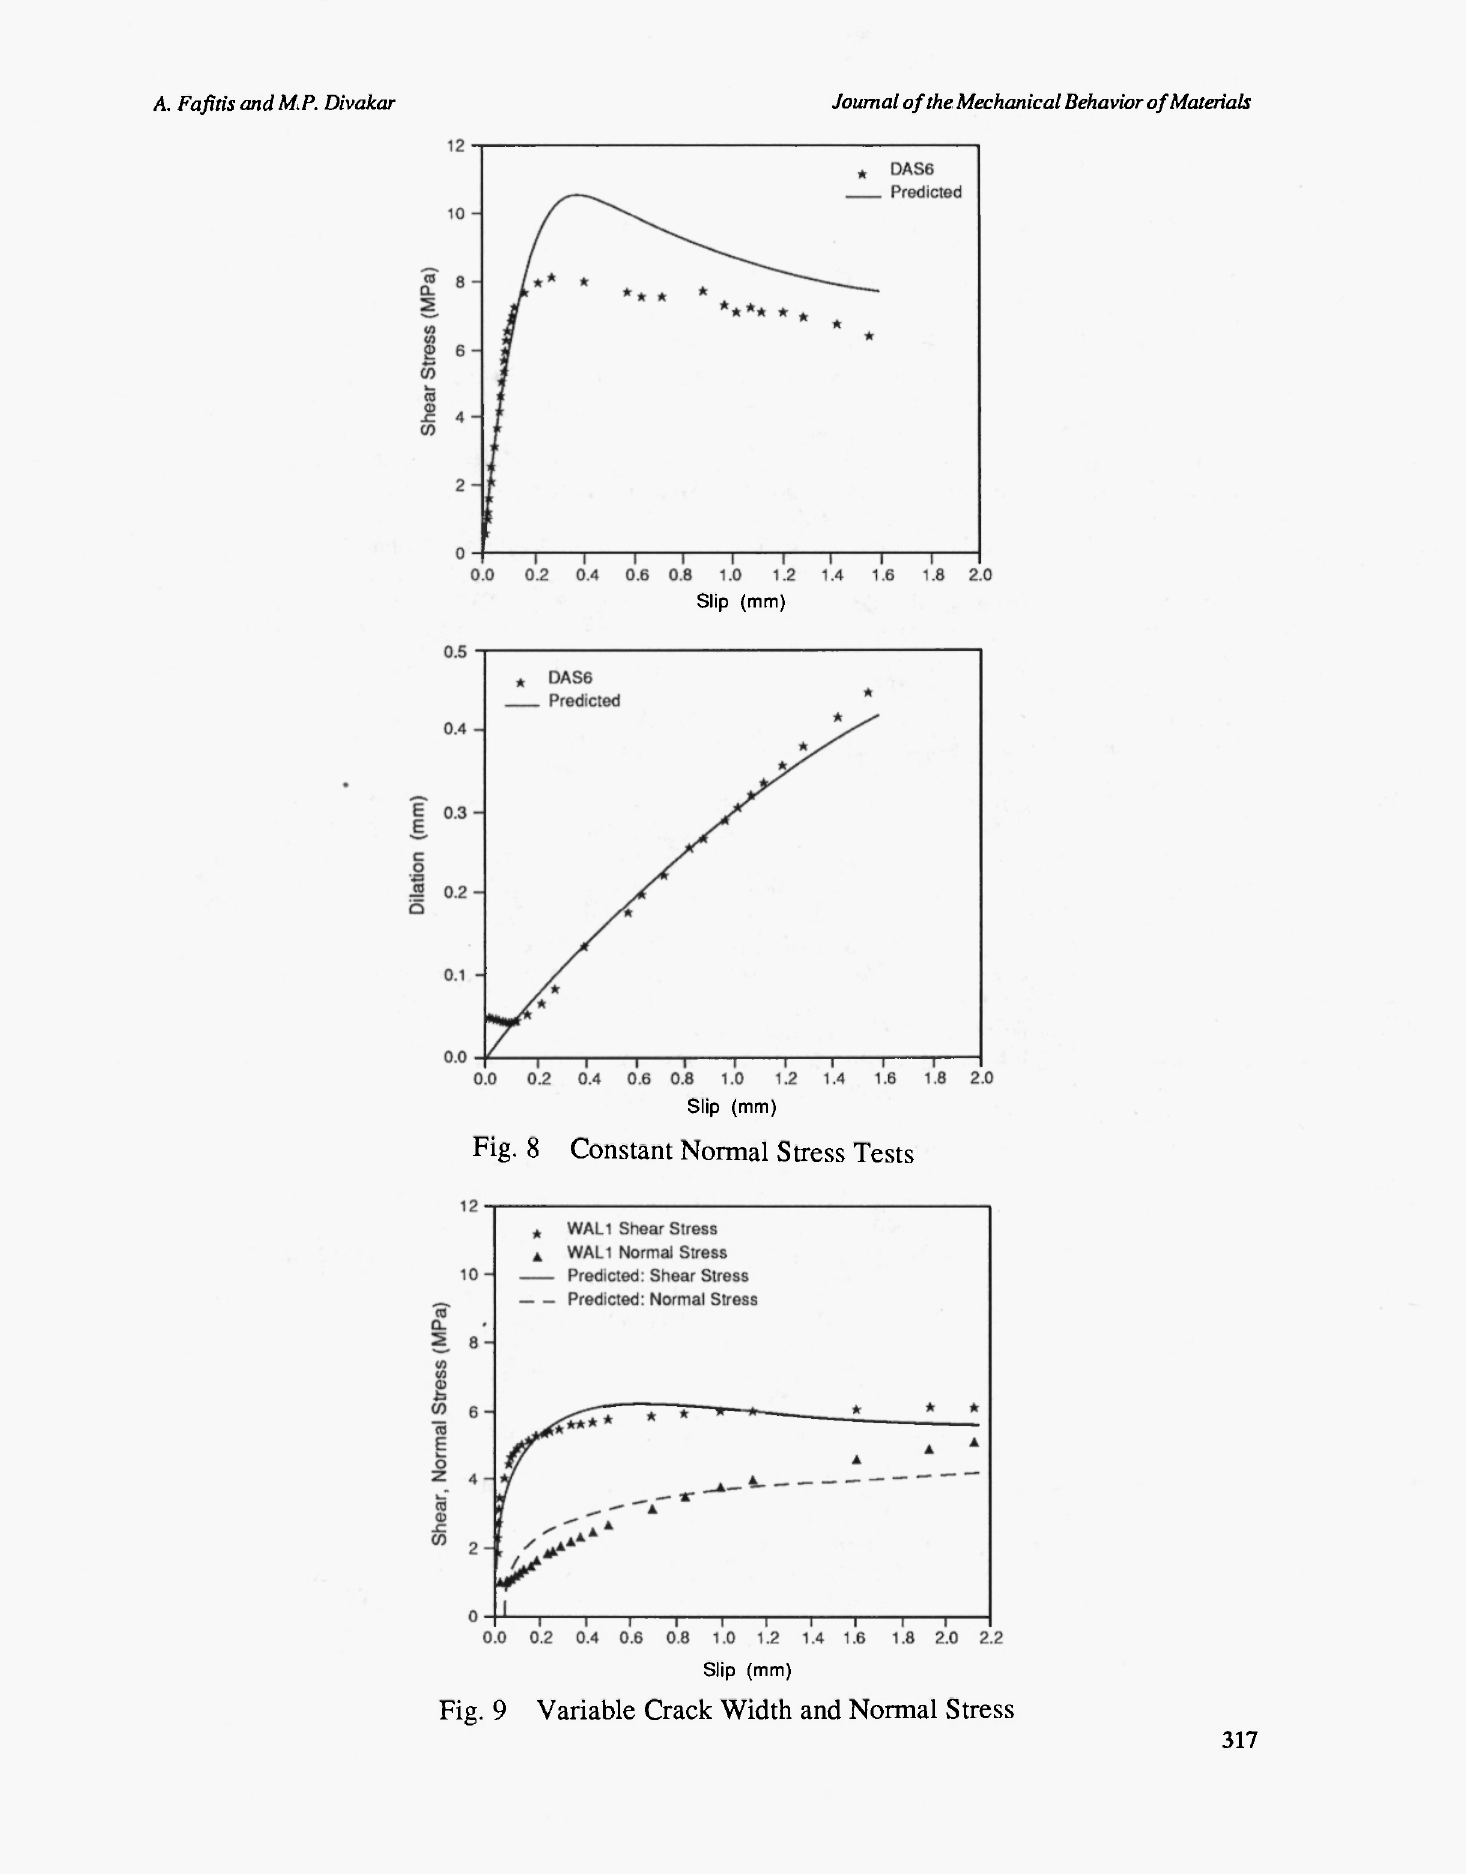
Fig. 9 Variable Crack Width and Normal